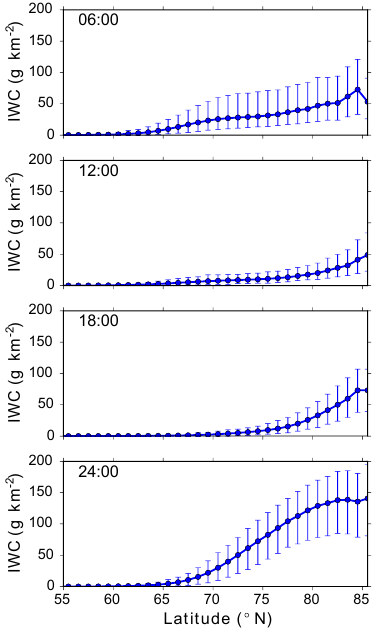
Figure 8. Median IWC values for July 2007–2013 as a function of latitude for different local times. No threshold has been applied, IWC values of zero (no PMCs) are included. The vertical bars rep- resent the lower and upper quartile of the data.